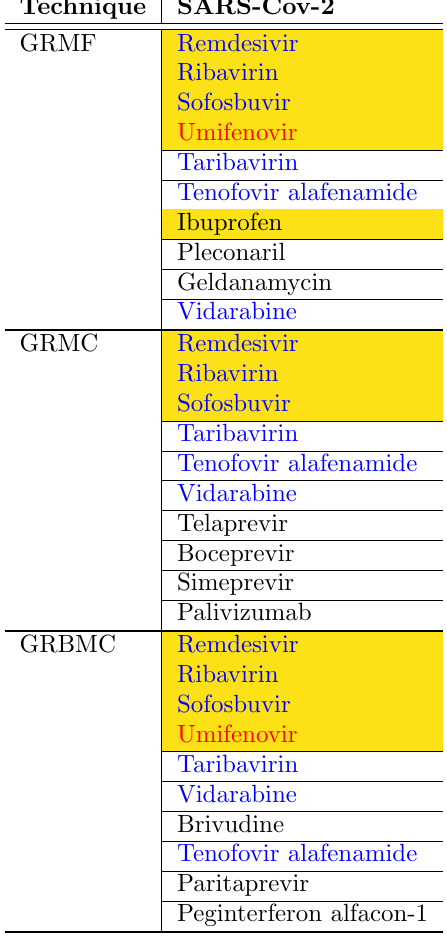
Table 3. Top-10 drugs predicted for SARS-Cov-2 by the DVA computational